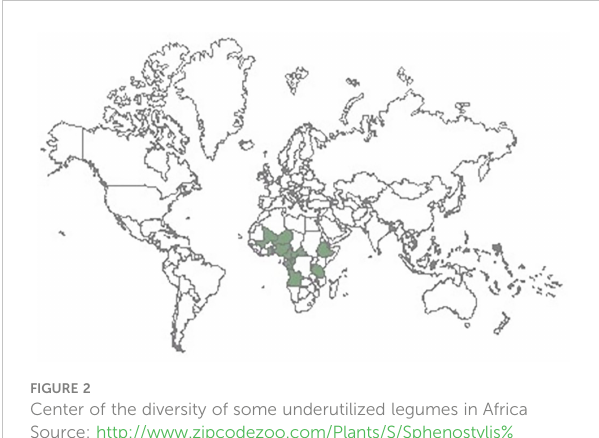
FIGURE 2 Center of the diversity of some underutilized legumes in Africa Source: http://www.zipcodezoo.com/Plants/S/Sphenostylis% 5Fstenocarpa/Default.asp (February 19, 2023).